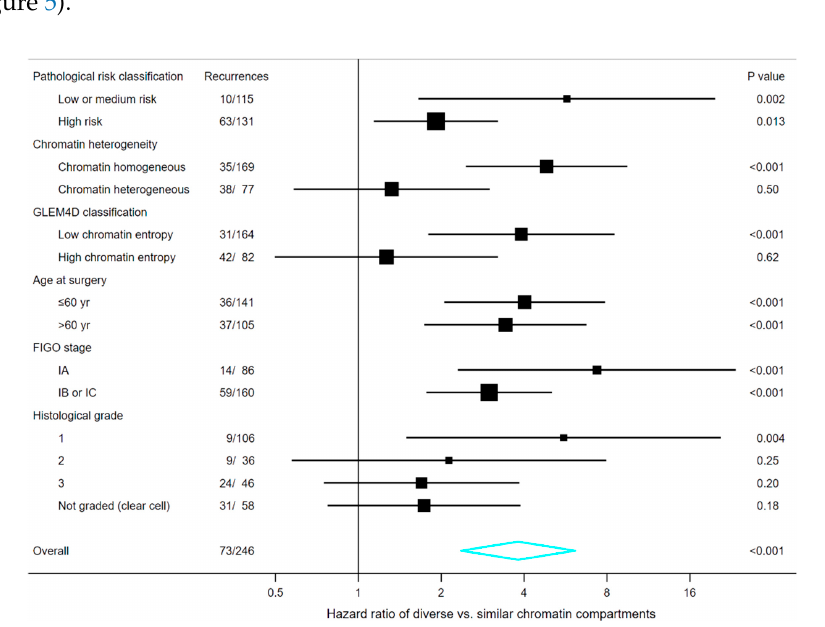
Figure 4. Forest plot illustrating the hazard ratio and 95% confidence interval of the marker of diversity of chromatin compartments in subgroups of patients with ovarian carcinoma. Pathological high-risk tumours were defined as those with either clear cell histology, poor di ff erentiation or both moderate di ff erentiation and FIGO stage IB or IC, while other tumours were defined as low or medium risk [35]. GLEM4D classifications refer to the marker trained and tested by Nielsen et al. [9] using the same ovarian carcinoma cohort as the marker of diversity of chromatin compartments. FIGO, International Federation of Gynecology and Obstetrics; GLEM4D, four-dimensional grey level entropy